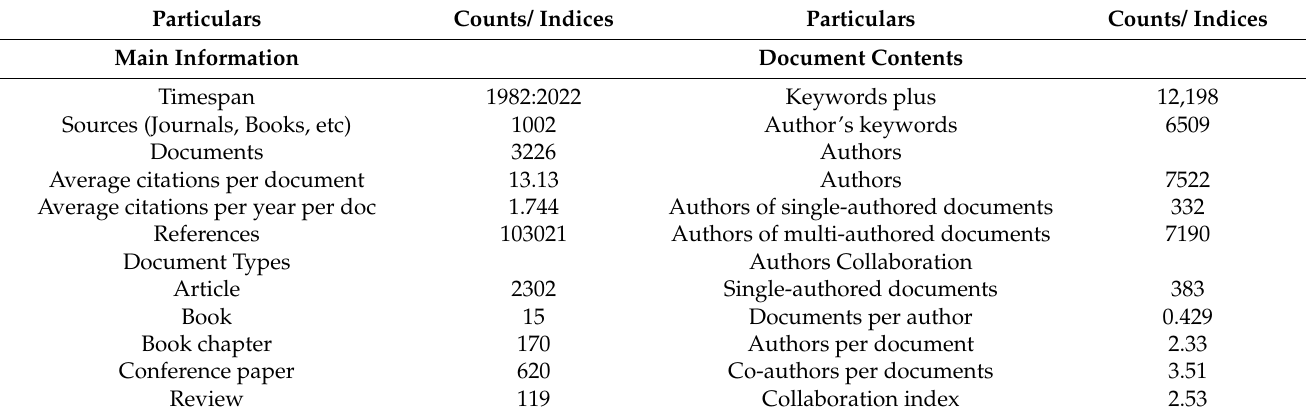
Table 2. Summary of data used in this